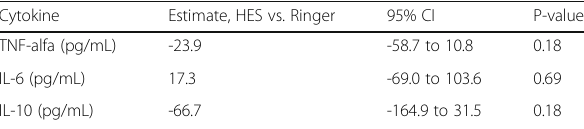
Table 82 (abstract A257). Mean differences in delta cytokine concentrations from baseline to day 2 in patients with severe